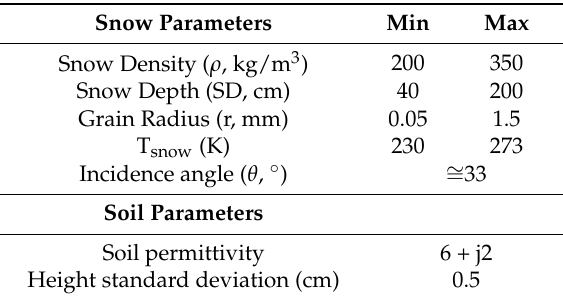
Table 2. List of the DMRT-QCA model inputs.